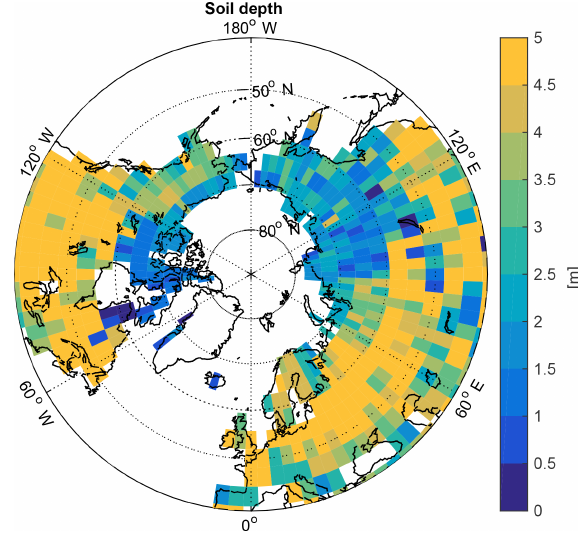
Figure A8. Prescribed soil depths after Carvalhais et al.